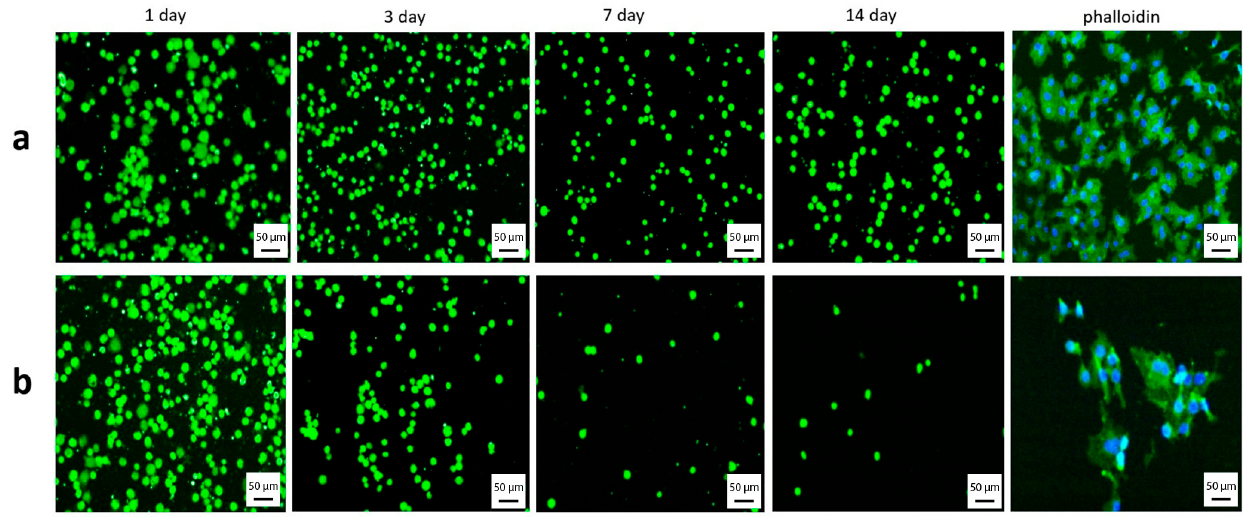
Figure 7. EA.hy926 cell distribution maps on substrates: ( a )—T1 surface, ( b )—T2 surface after cul-